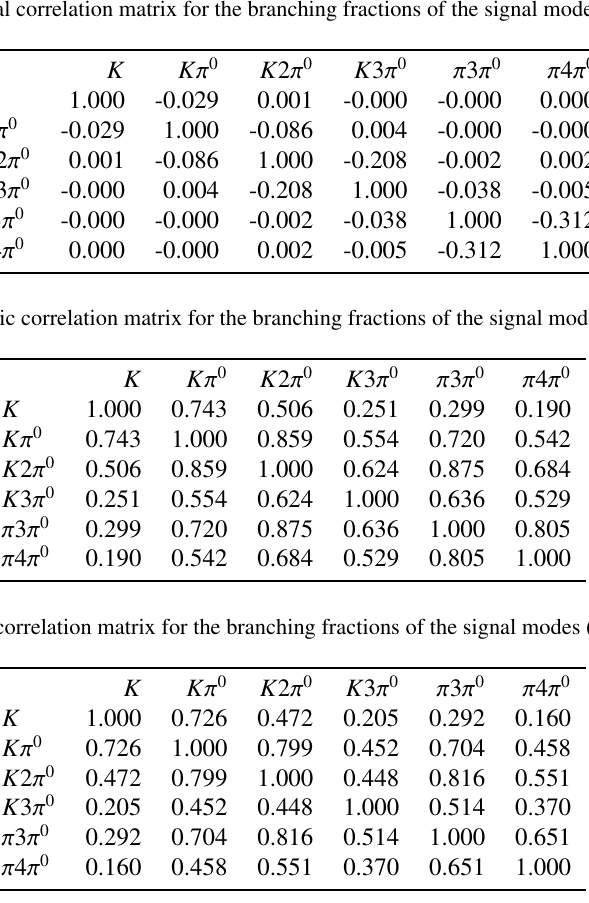
Table 2. Statistical correlation matrix for the branching fractions of the signal modes (preliminary).